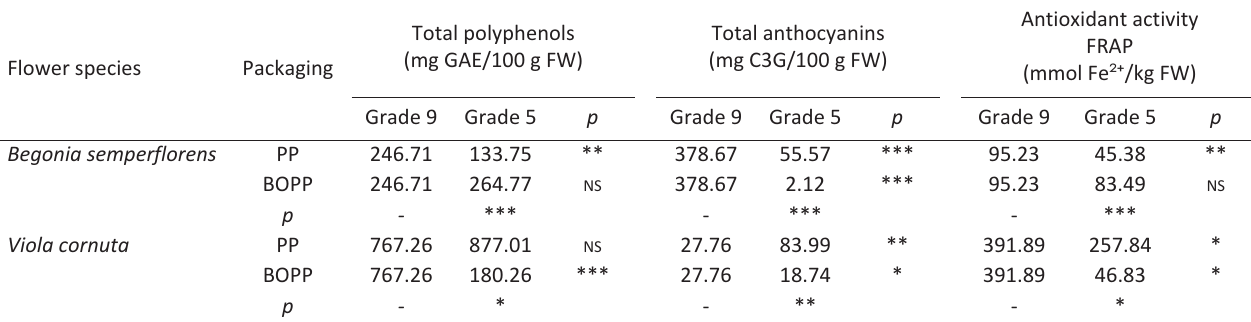
Table 2 ­ Total polyphenols, total anthocyanins, and antioxidant activity (FRAP) at grade 9 (day of harvest) and grade 5 (i.e. limit of marketability, corresponding to 9 days for begonias and 14 days for violas) of visual quality scale of B. semperflorens and V. cornuta flowers stored at 4°C in two different